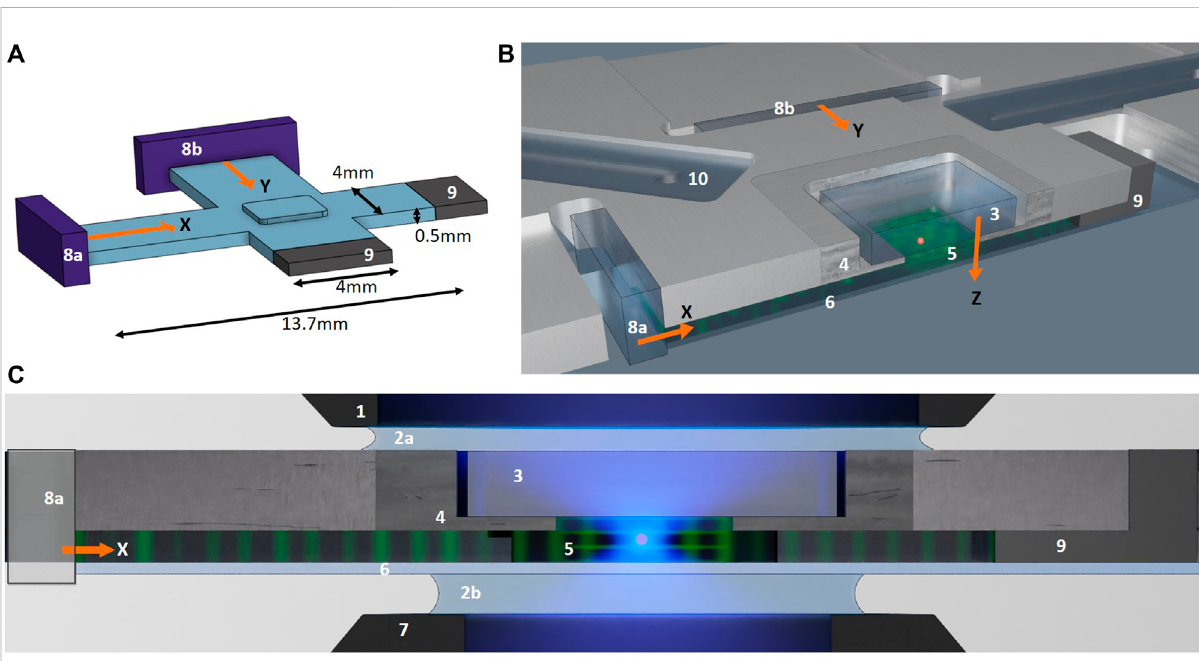
FIGURE 1 Micro fl uidic chip: (A) Schematic showing the three orthogonal fl uid channels (blue) of the chamber: two long crossed horizontal channels for propagating the ultrasound from the side-transducers (8a, 8b, purple) and one short vertical channel where the crossed side-channels intersect for propagating the ultrasound from the top-transducer (not shown). Schematics from (B) an angled top view and (C) a cross-section of the chip with a through-cut along the x-channel as marked with a red dashed line in Figure 2A. The propagation direction of the ultrasound from the three orthogonalLiNbO 3 transducersinx-,y-and z -direction(8a,8b,and3)areindicatedwithorangearrows.Alltransducersareindirectcontactwiththe fl uidandgeneratestandingwavesinthethreedirectionsbyre fl ectionoftheacousticwavesattheendofeachchannel:withthebottomcoverslip(6) for the top-transducer and the steel re fl ectors (9) for the side-transducers. The particle manipulation and imaging is performed where the three standing waves intersect under the top transducer (3) and the aluminum spacer (4). (C) shows the chip in the high-NA imaging set-up, with blue illumination light and immersion oil (2a) between the top of the chip and the immersion condenser lens (1) and immersion oil ( n = 1.33, 2b) between thebottomofthechipandtheimmersionobjectivelens(7)respectively.Thenumbersrefertothecomponentslistedatthebottomofthe fi gure,and fi gures are not to